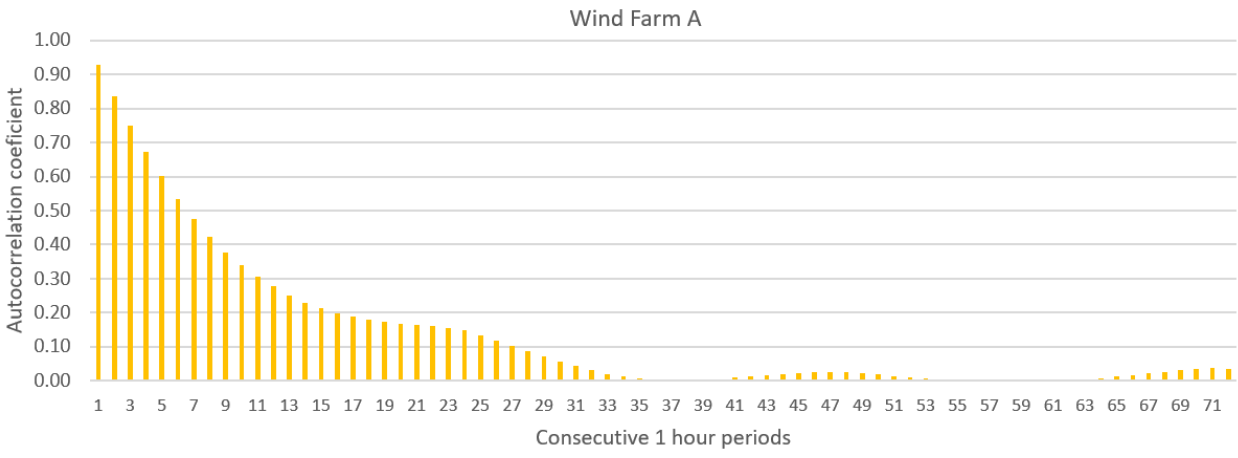
Figure 2. Autocorrelation function (ACF) of the Wind Farm A energy generation time series.